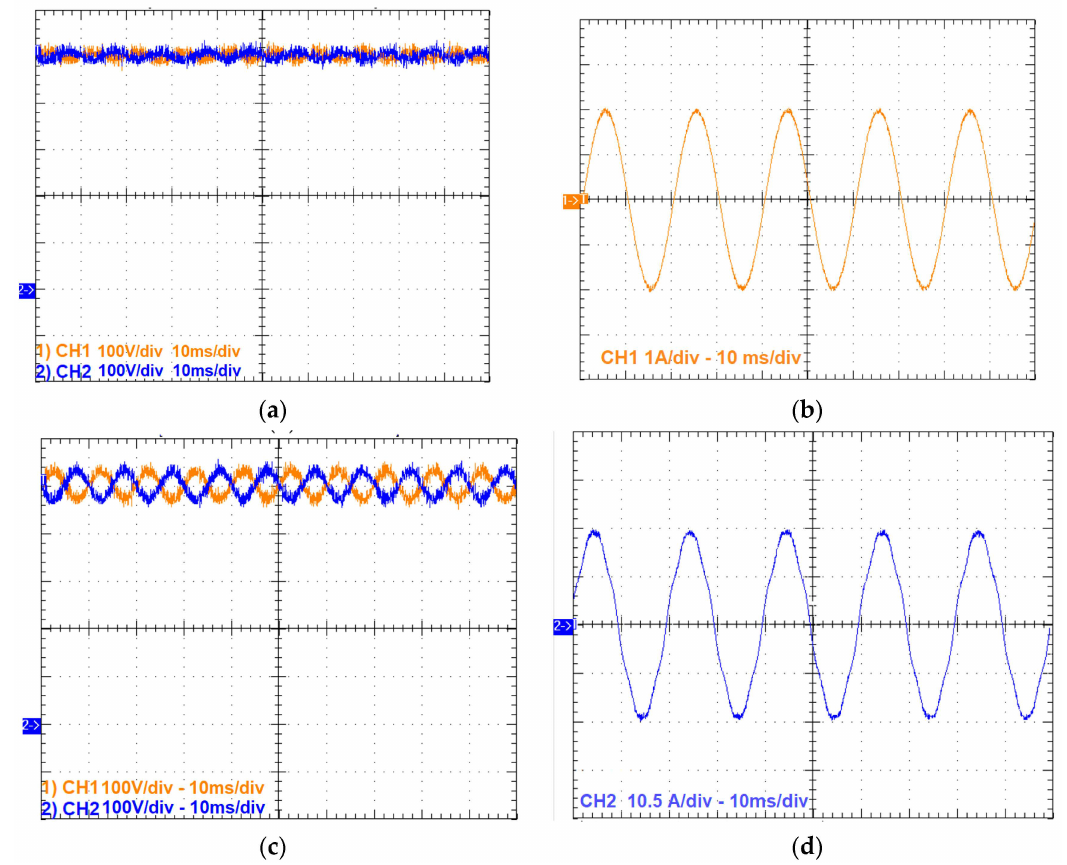
Figure 3. Experimental results of a five-level NPC at 1 kW and 10 kW with ( a ) capacitors voltages V dc1 and V dc2 at 1 kW. ( b ) Output current at 1 kW, ( c ) capacitors voltages V dc1 and V dc2 at 10 kW, and ( d ) output current at 10